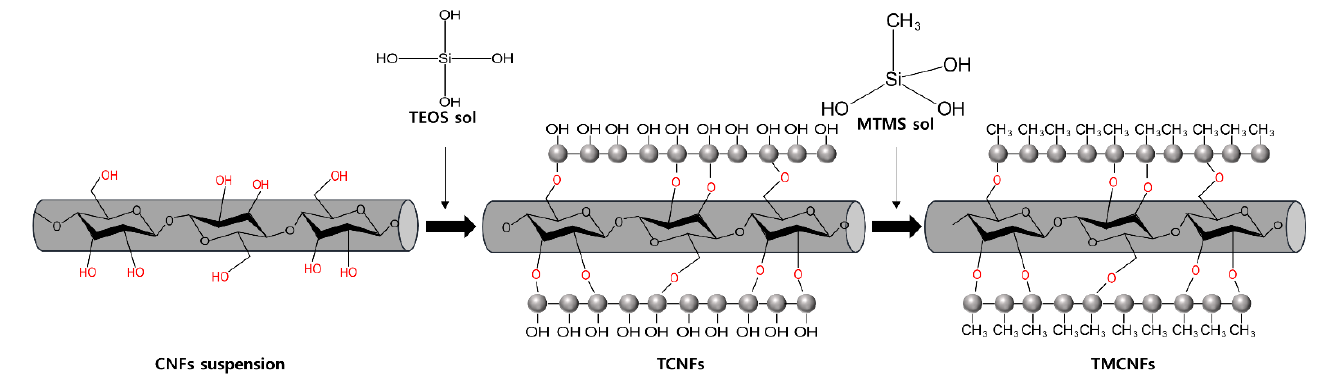
Figure 2. Schematic illustration of surface modification of CNFs using TEOS and MTMS.